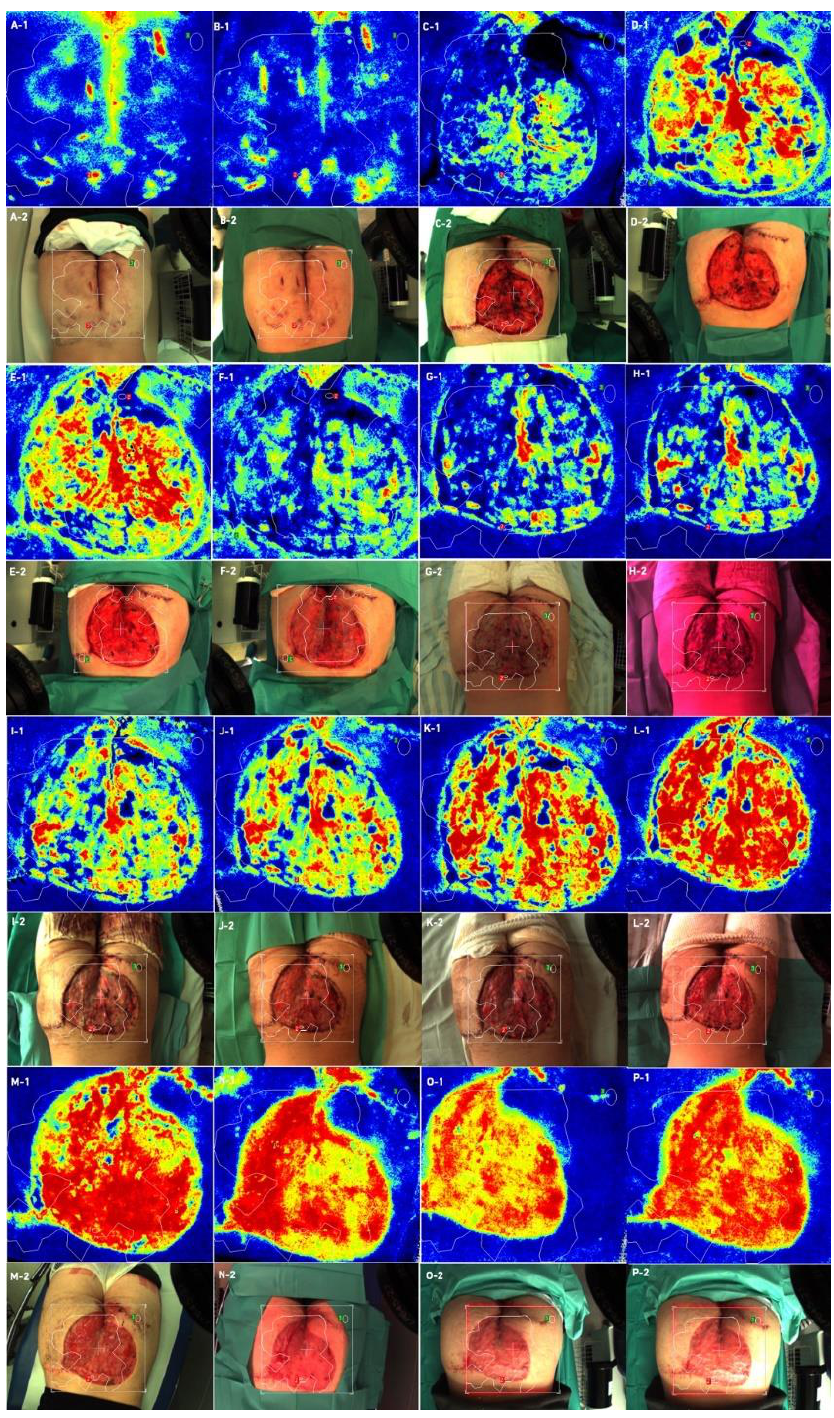
Figure 5. Case 1 — Laser speckle analysis and wound image, A1 – A2 — Patient before admission, B1- Figure 5. Case 1—Laser speckle analysis and wound image, ( A1 , A2 )—Patient before